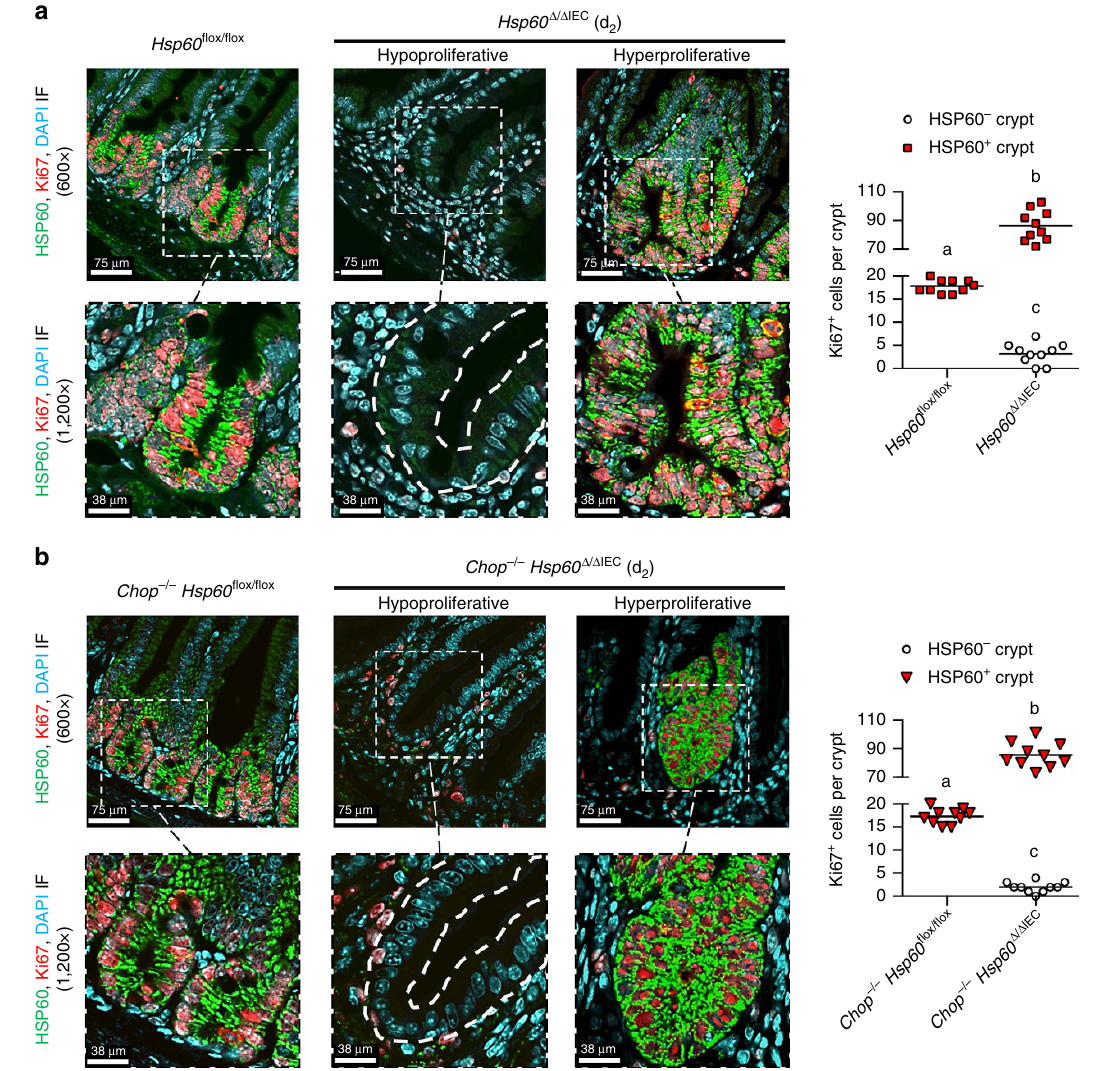
Figure 3 | HSP60 levels determine the proliferative capacity of the crypt. ( a ) IF co-staining of HSP60 and Ki67 on jejunal sections including detailed images in higher magnification of Hsp60 flox/flox controls and Hsp60 D / D IEC mice (DAPI stains nuclei in cyan; dotted lines indicate localization of cryptal epithelium). Quantification of Ki67-positive cells in HSP60-positive and HSP60-negative crypts ( N ¼ 5; 2 regions per mouse). ( b ) Parallel evaluation as in ( a ) for Chop (cid:2) / (cid:2) Hsp60 D / D IEC mice and Chop (cid:2) / (cid:2) Hsp60 flox/flox controls. Lines in the dot plots indicate mean numbers. (a,b,c), significantly different from each other. One-way analysis of variance (ANOVA) and appropriate post-hoc test were used for statistical